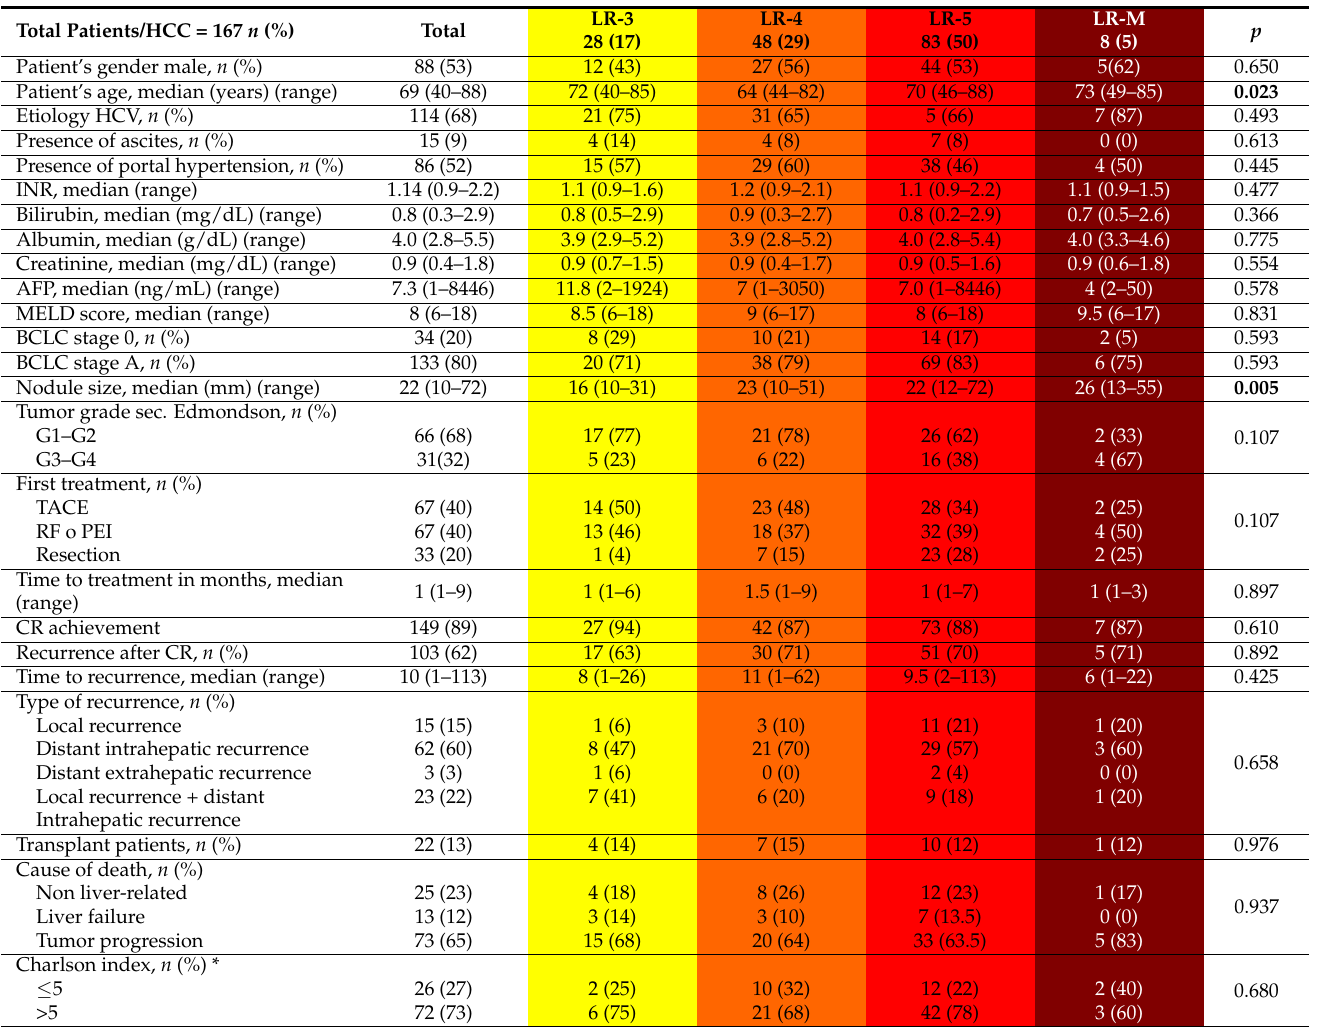
Table 3. Patients and tumor characteristics in different CEUS LI-RADS